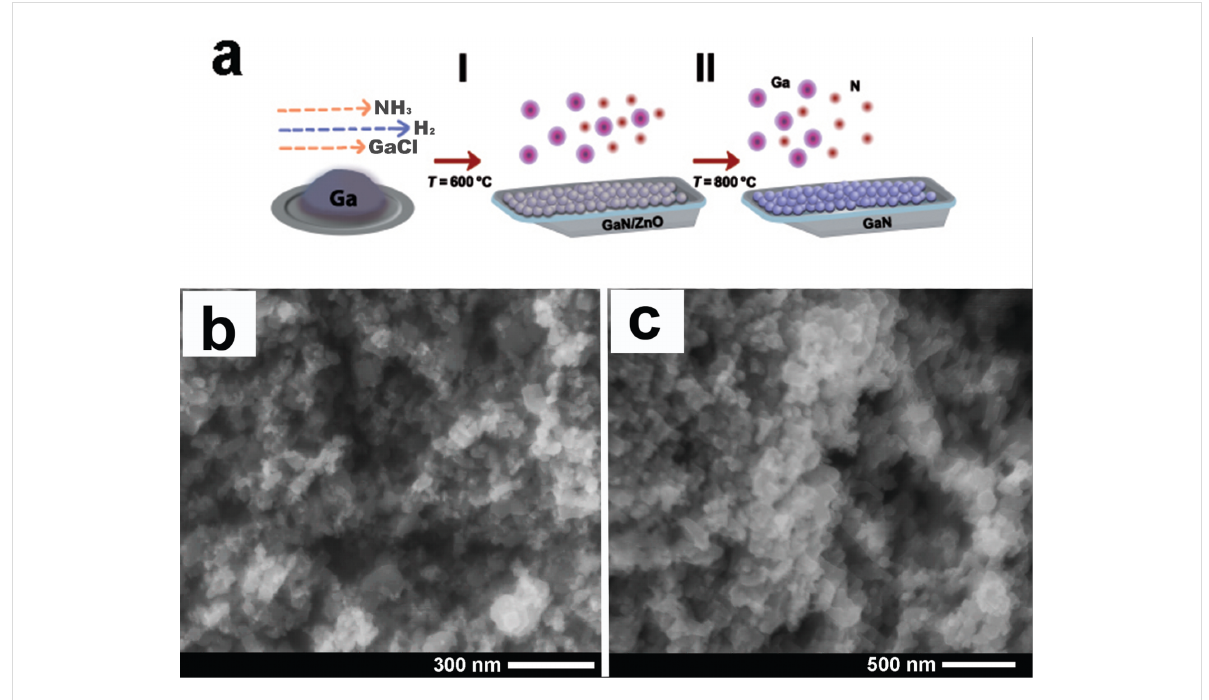
Figure 1: Schematic representation of the GaN growth process on ZnO nanoparticles. (a) I – the nucleation process of GaN at low temperature, II – the high temperature step for layer growth and sacrificial ZnO core decomposition. SEM images of (b) ZnO nanoparticles and (c) GaN nanoparticles grown on a sacrificial layer of ZnO.